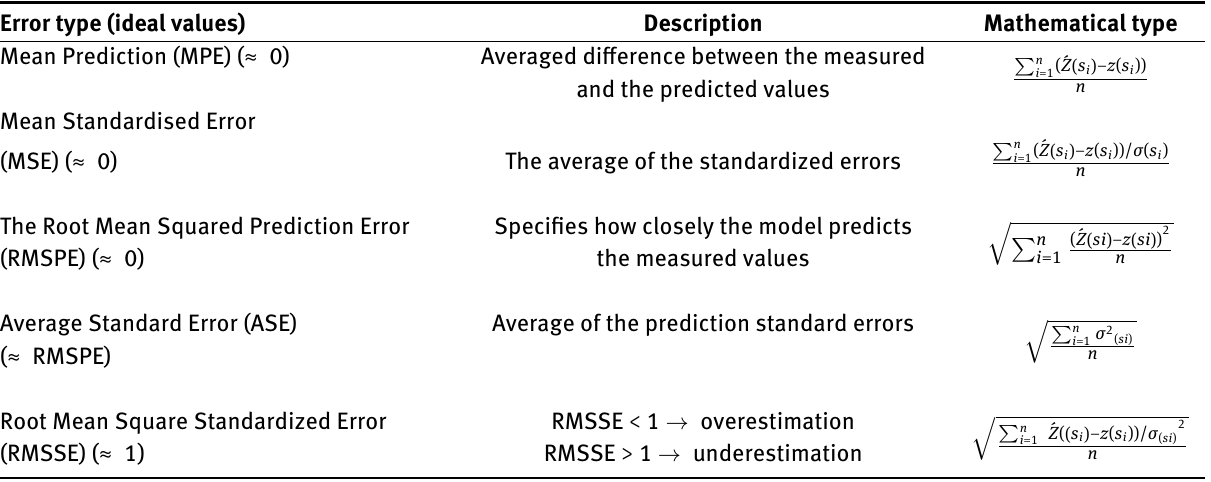
Table 3: Error types used in the cross-validation model Error type (ideal